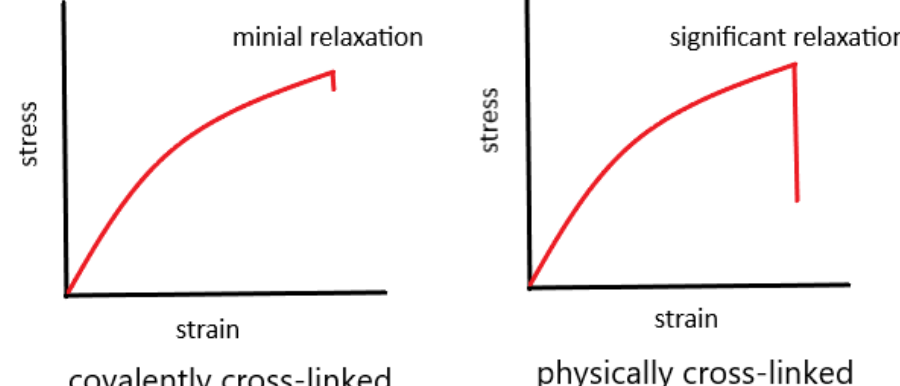
Figure 4. Schematics of stress relaxation tests for covalently cross-linked and physically cross-linked hydrogels. In the test, the hydrogel samples are stretched to a set strain and held to observe if the stress decays as a function of time. Physically cross-linked hydrogels exhibit substantial stress relaxation (mechanical instability). Covalently cross-linked hydrogels demonstrate small stress